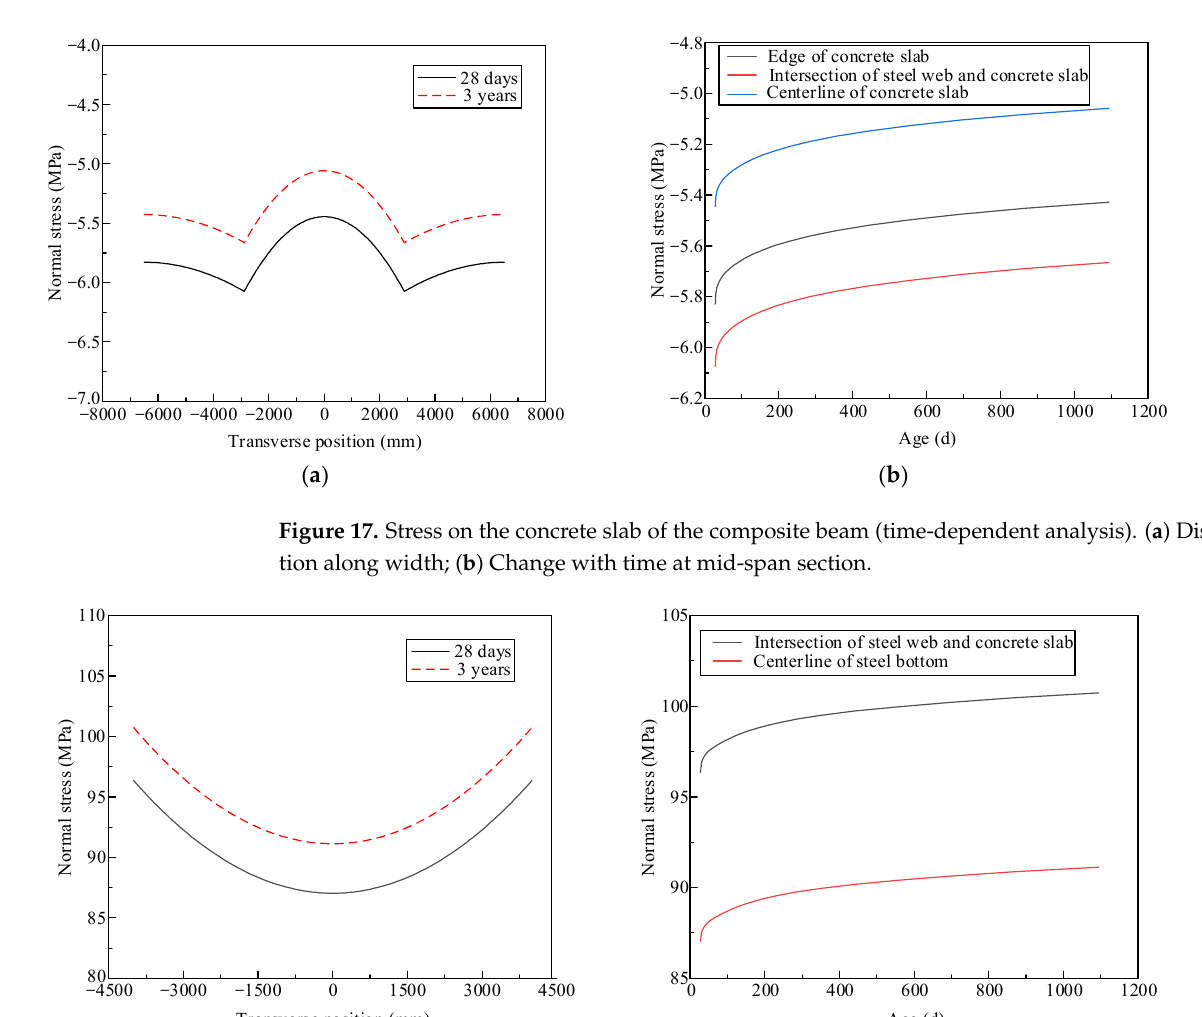
( b ) Figure 16. Warping intensity function of the steel bottom induced by shear deformation of the com- posite beam (time-dependent analysis). ( a ) Distribution along span; ( b ) Change with time at support section. Figure 17 shows the stress distribution on the concrete slab and the variation with time. According to Figure 17a, the compressive stress at the edge of the concrete slab de-